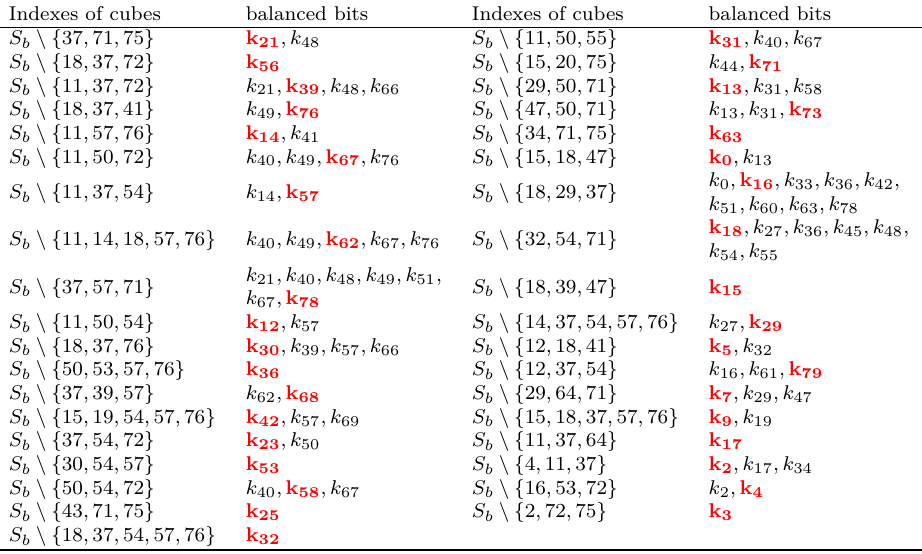
Table 7: Valuable cubes for attacking 808-round Trivium . Sorted by the deducing order. Indexes of cubes balanced bits Indexes of